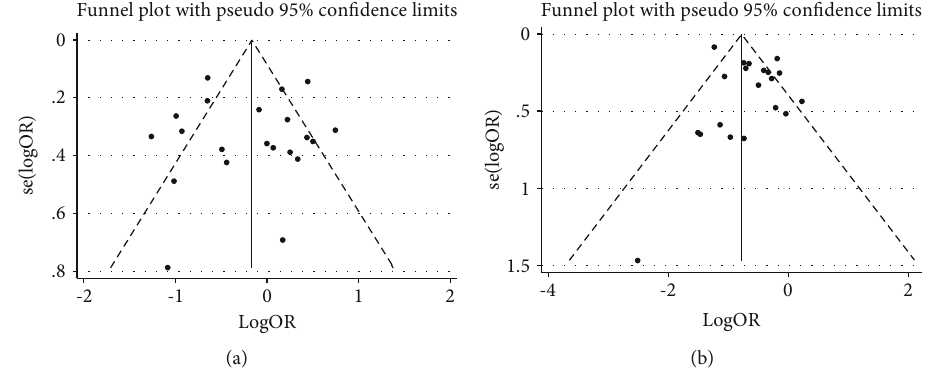
Figure 4: Funnel plot of the association between Helicobacter pylori infection and esophageal cancer: (a) esophageal squamous cell carcinoma; (b) esophageal